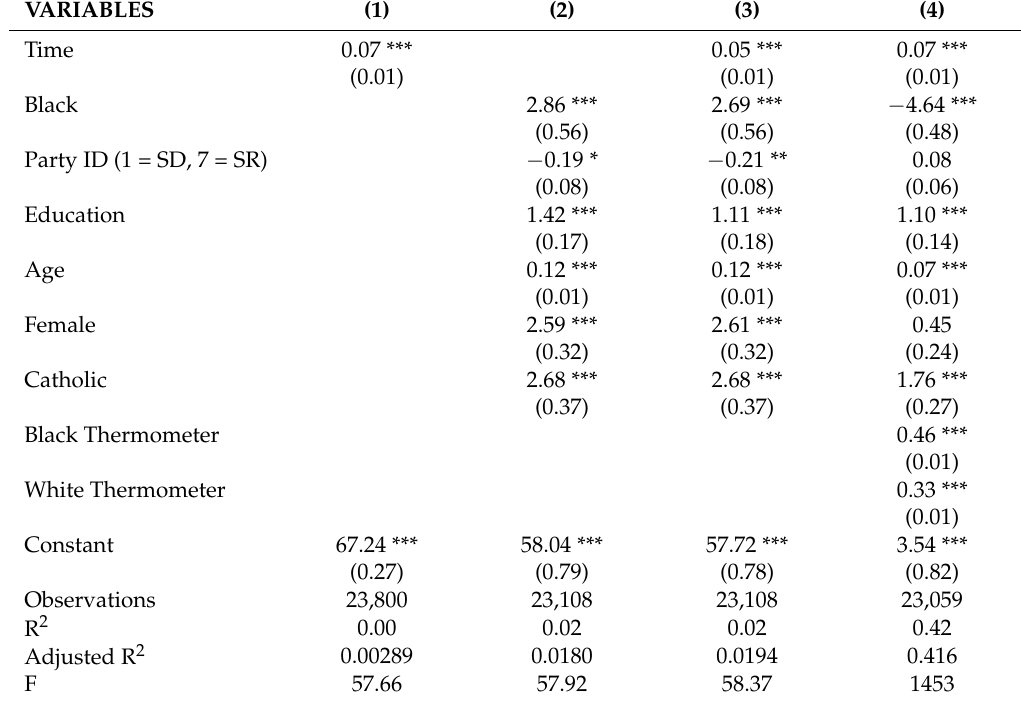
Table 2. Impact of demographics and time on Jewish thermometer ratings, ANES